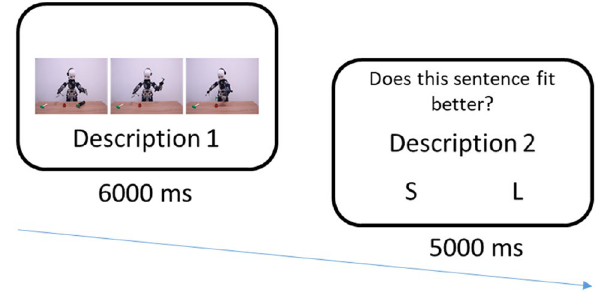
Figure 3. Experiment 1 trial sequence.